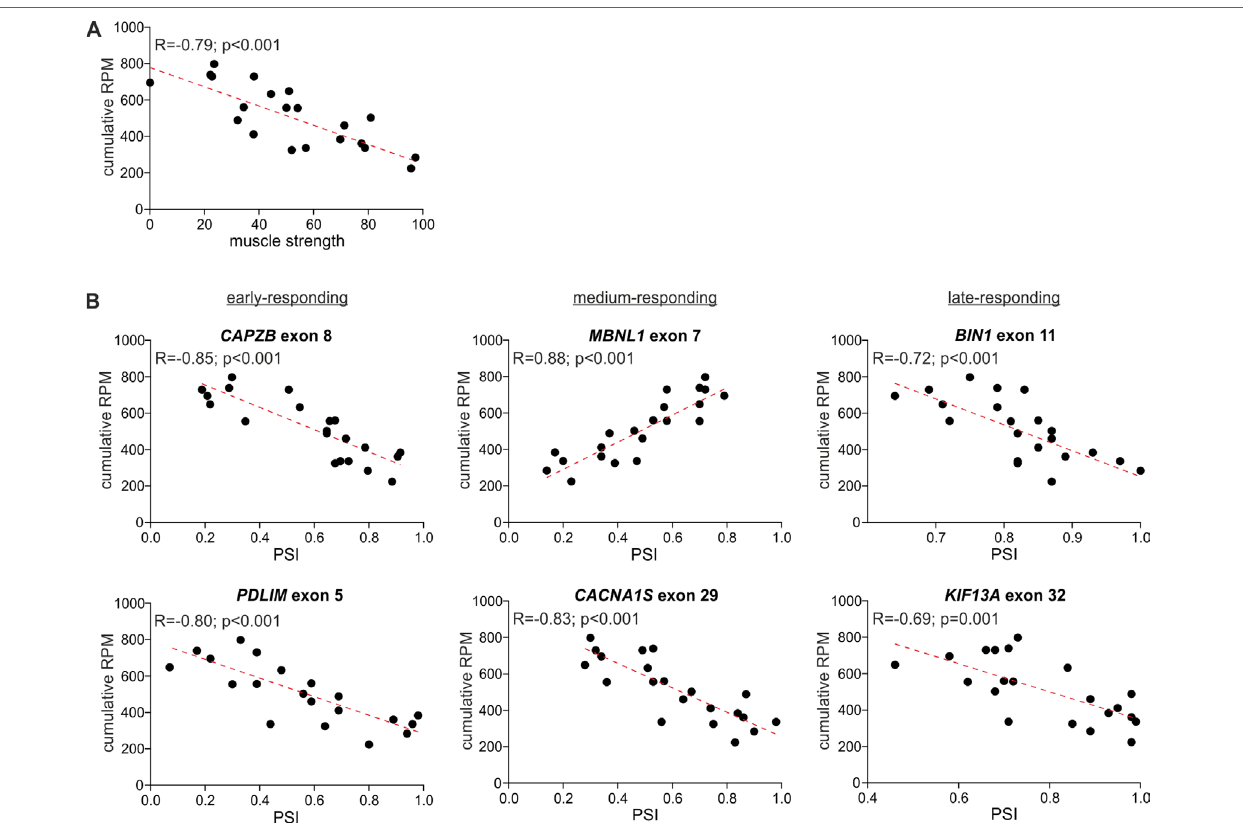
FIGURE 6 | Correlation of global circRNA level with disease severity. For each plot, the R -value, p -value, and the trendline (red-dotted line) are shown. (A) A scatter plot showing the correlation of global circRNA levels normalized as RPMs ( Y -axis) and muscle strength ( X -axis). (B) Scatter plots showing correlations of global circRNA levels ( Y -axis) and PSI values of early-, medium-, and late-responding exons alternatively spliced in DM1 (X-axis). Each dot represents an individual TA